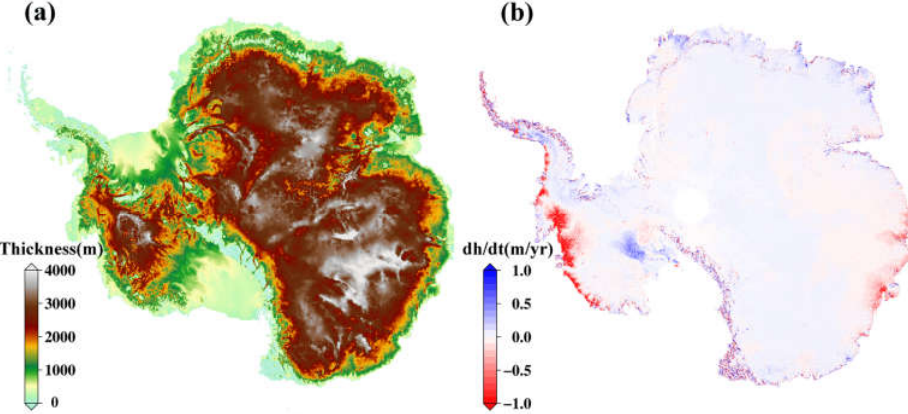
Figure 2. ( a ) The BedMachine ice thickness of the AIS [3]. ( b ) Surface elevation changes of the AIS during 2013–2020.